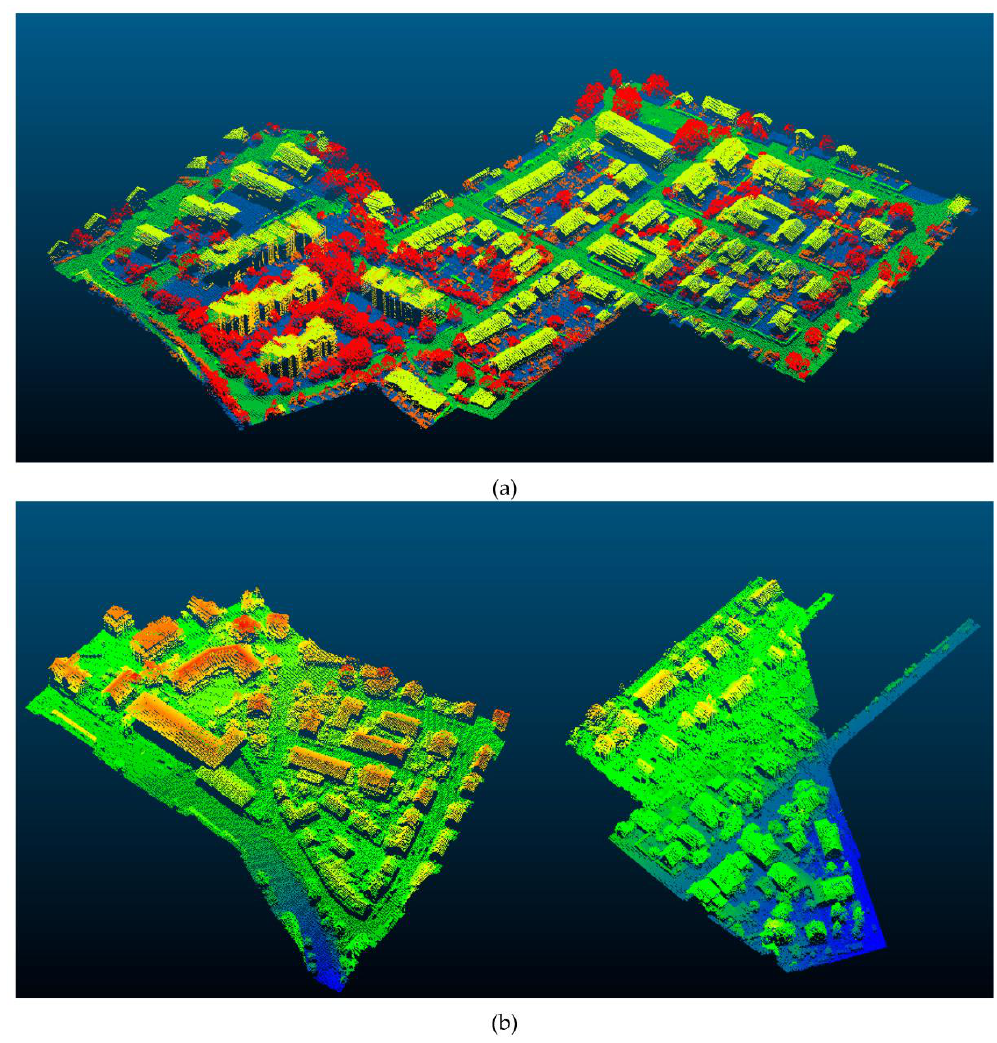
Figure 4. ( a ) The training set: the color encoding shows the assigned semantic class labels (Powerline: blue; Low Vegetation: Navy; Impervious Surfaces: green; Car: lime; Fence/Hedge: lawngreen; Roof: yellow; Façade: gold; Shrub: orange; Tree: red). ( b ) The testing set: The colors blue to red represent the z values of the points.